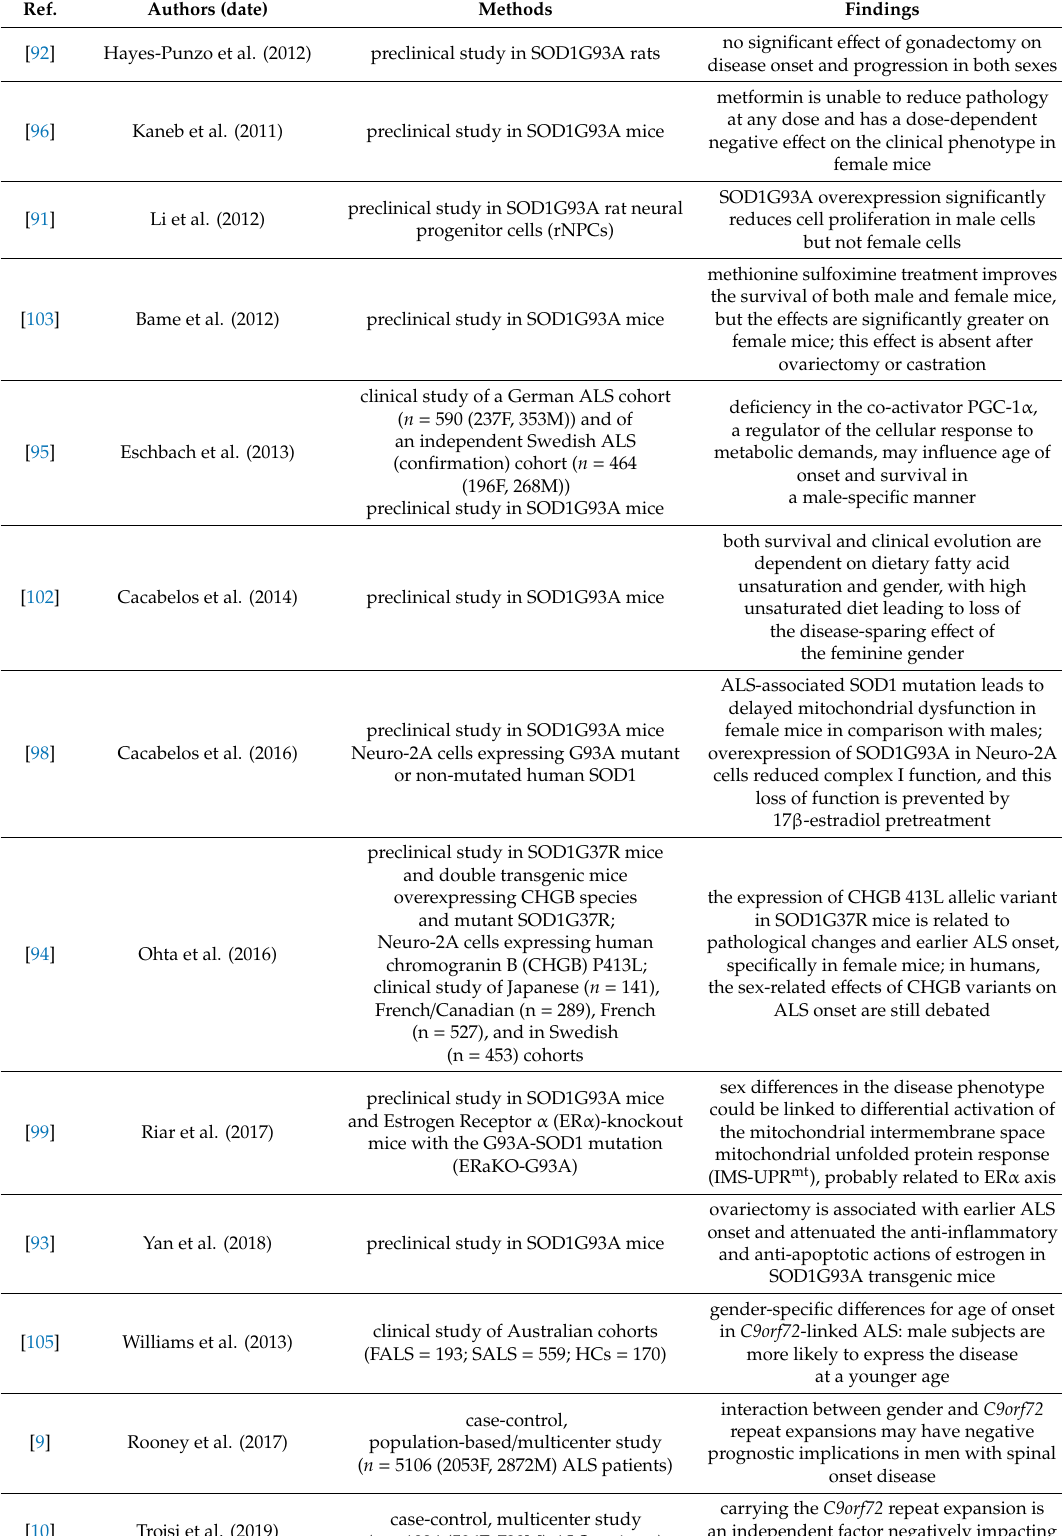
Table 1. Research studies analyzing the role of sex–genetics interplay in the pathogenesis and clinical phenotype of